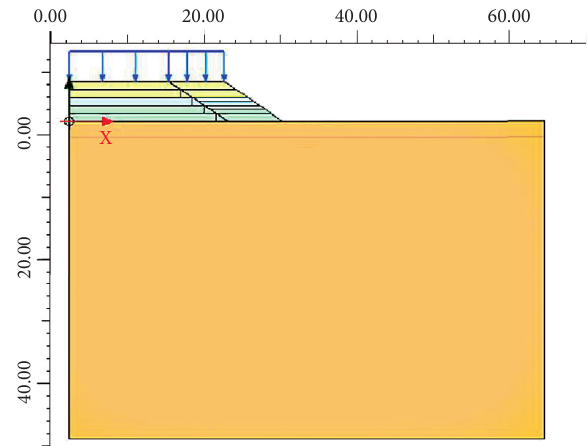
Figure 1: Finite element model schematic